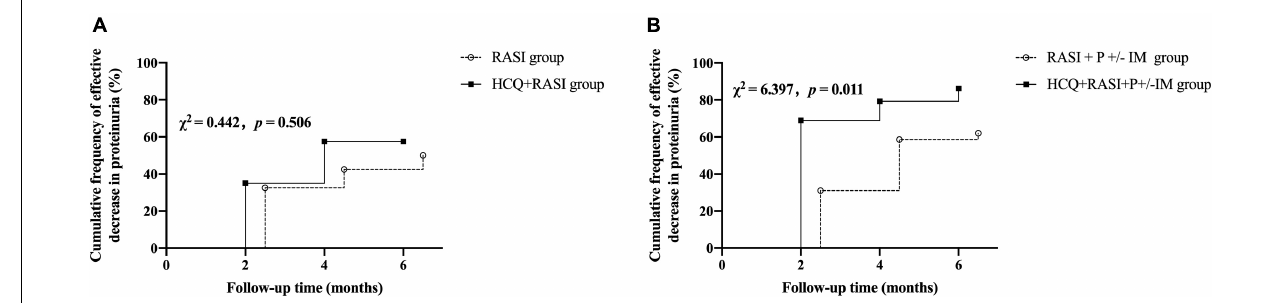
FIGURE 3 | The cumulative frequency of patients with an effective decrease in residual proteinuria during the follow-up period. (A) The RASI group vs. the HCQ + RASI group. (B) The RASI + P ± IM group vs. the HCQ + RASI + P ± IM group. TABLE 4 | Indicators related to residual proteinuria and renal function during follow-up of matched IgAN patients. Valuable